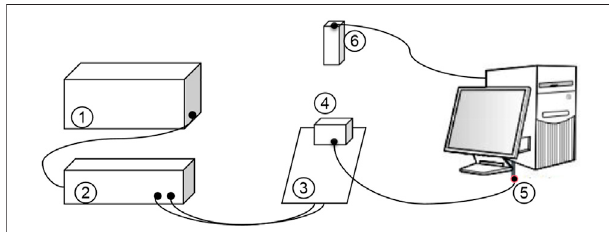
FIGURE 5 | The response testing platform of EWDs. ① Waveform generator. ② Voltage ampli fi er. ③ EWD panel. ④ Colorimeter. ⑤ Computer. ⑥